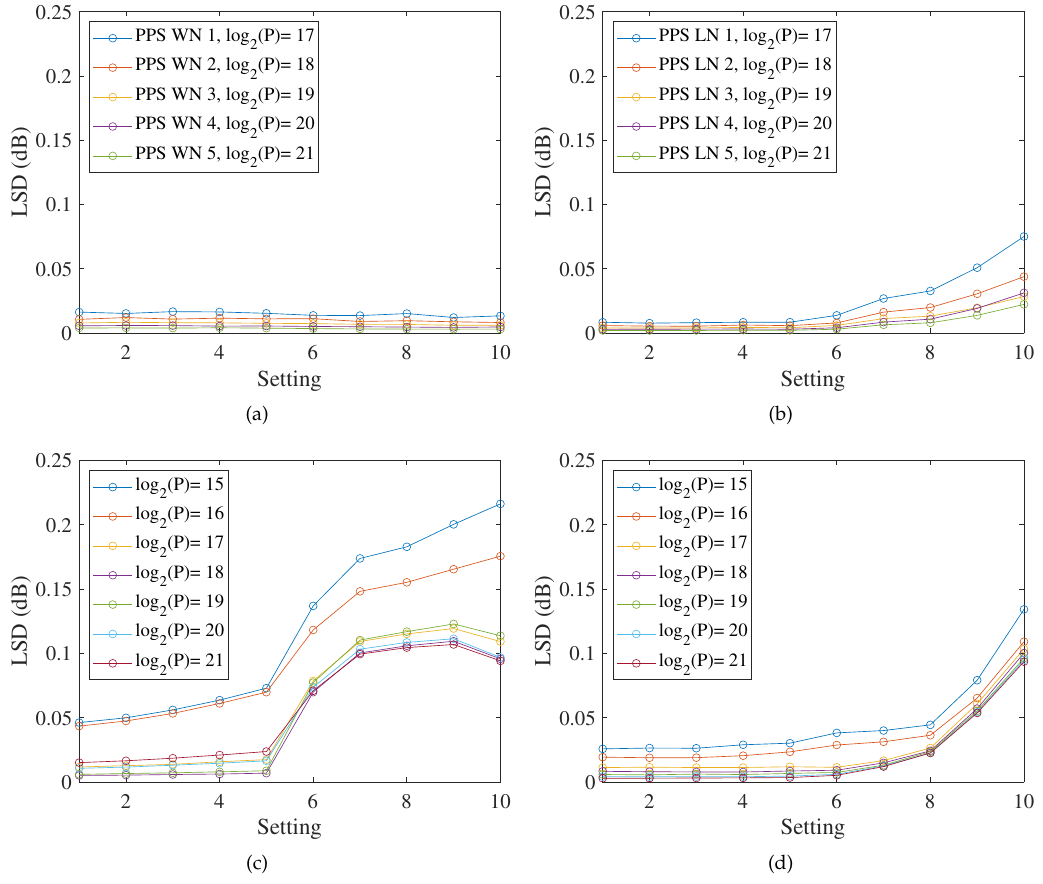
Figure 4. Log-spectral distance in the band [100, 18,000] Hz at the different settings for ( a ) PPSs for WN filters, ( b ) PPSs for LN filters, ( c ) MLSs, ( d ) exponential